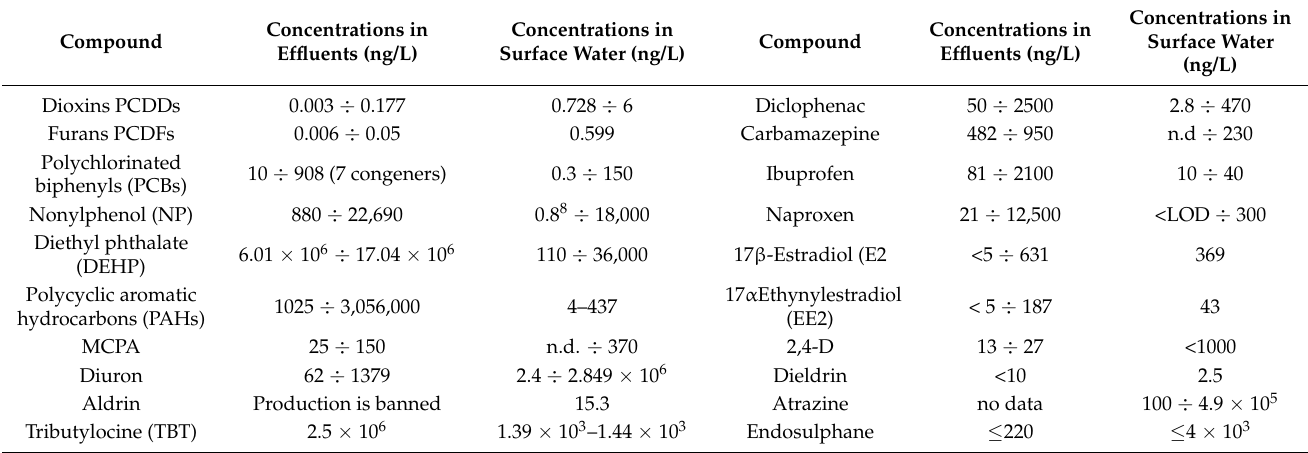
Table 6. The values of the concentrations of organic micropollutants (data from